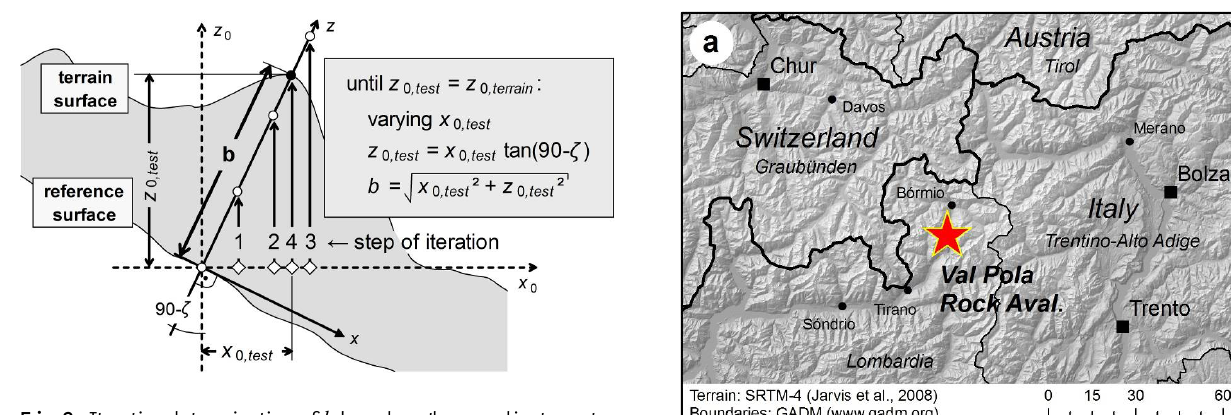
Fig. 2: Iterative determination of b based on the coordinate system defined by the reference Fig. 2. Iterative determination of b based on the coordinate system plane. defined by the reference plane.